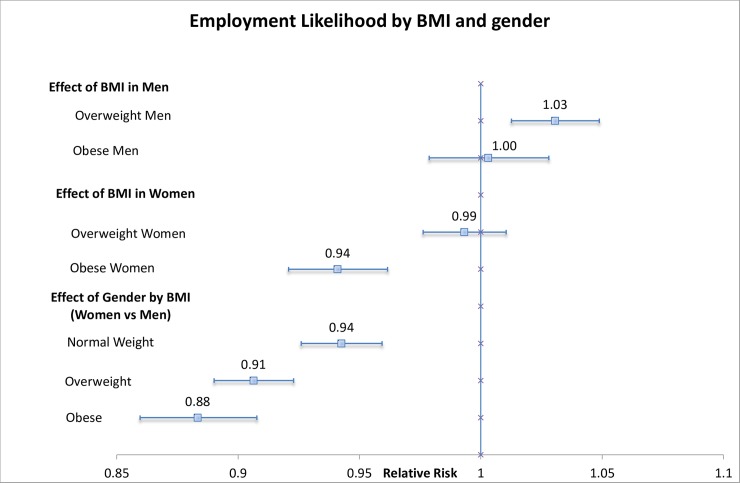
Relative Risk of being employed by BMI category.Note: The results are shown as relative risks (RRs), approximated from the Incidence Rate Ratios in the corresponding Poisson models. The model was adjusted for marital status, age, education, country level fixed effects, level of physical activity, smoking, drinking, and other chronic diseases. All relative risks can be combined on an additive scale, and refer to the likelihood of being employed when in the exposure category, compared to the reference category. A relative risk >1 means a greater likelihood of being employed, and a RR <1 means a lower likelihood of employment. p-value for effect modification by gender: p<0.0001 Source: OECD analysis of Harmonized SHARE + SHARE employment module, Release 6.0. The forest plot was created based on a template by [30].